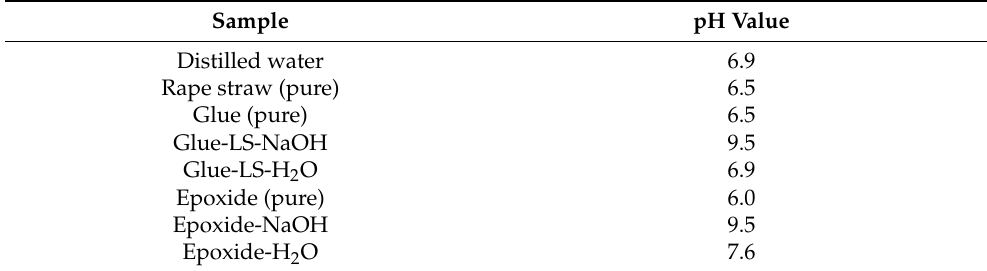
Table 3. pH values of the tested samples (the